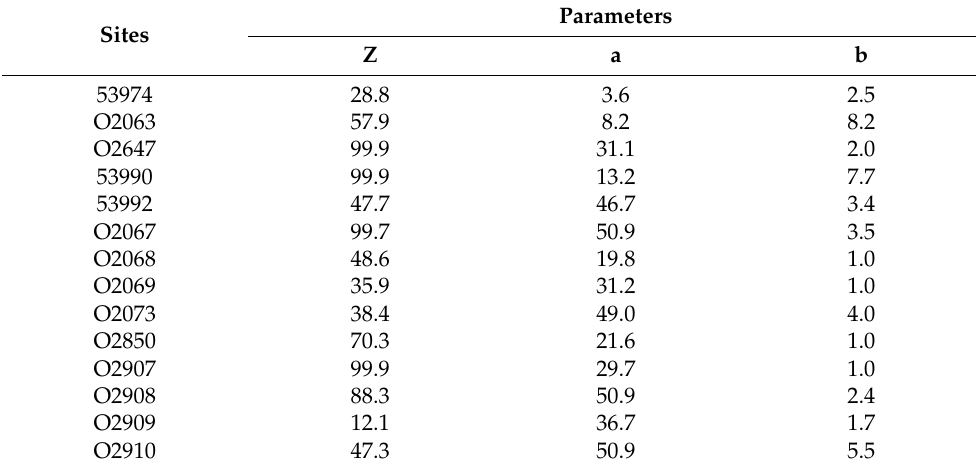
Table 4. The parameters related to the model of soil water balance.